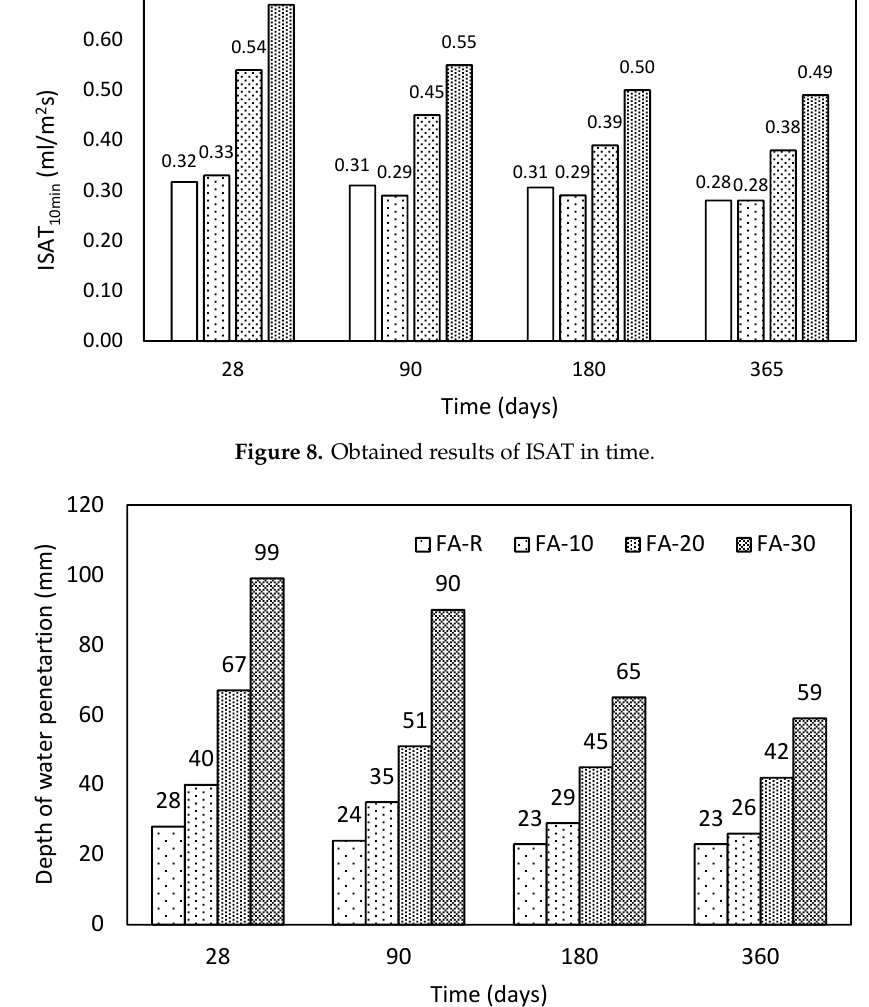
Figure 8. Obtained results of ISAT in time.